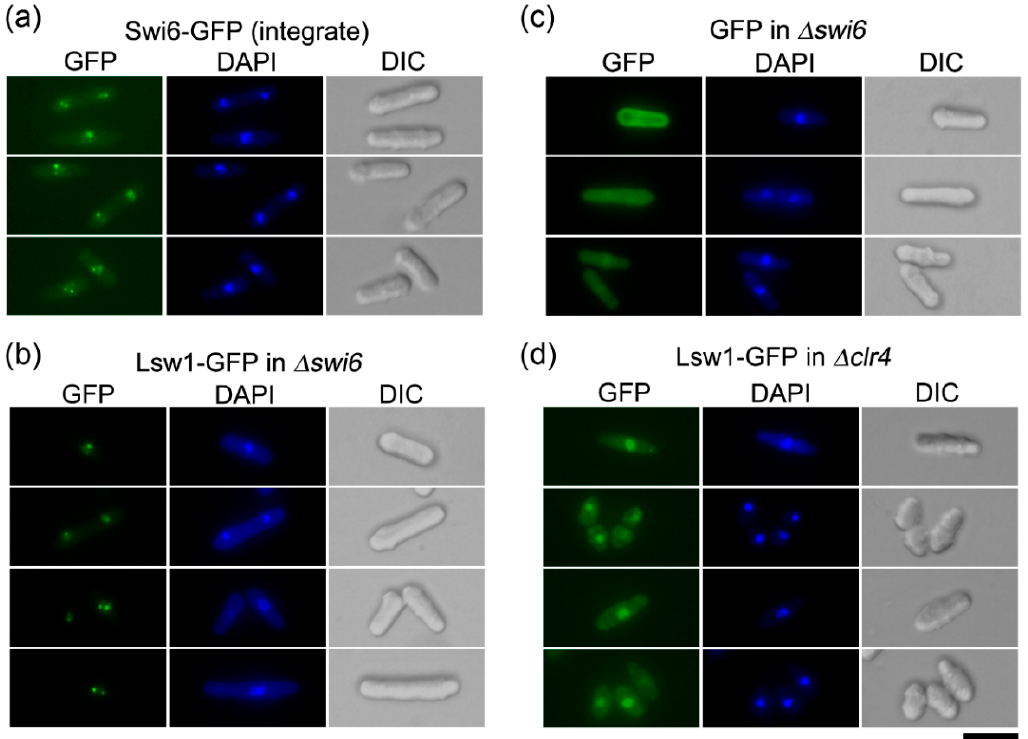
Figure 6. Lsw1 localizes to heterochromatin in a H3K9 methylation dependent manner. ( a ) Swi6-GFP (YTP1889) cells were grown in YES medium at 30 ◦ C overnight, then fixed with methanol. ( b , c ) ∆ swi6 cells (YTP1847) containing pGP4110-Lsw1 ( b ) or pGP4110 ( c ) were grown in minimal medium supplement with uracil and without thiamine at 30 ◦ C for 20 h, then fixed with methanol. ( d ) ∆ clr4 cells (YTP1840) containing pGP4110-Lsw1 were grown in minimal medium in the absence of thiamine at 26 ◦ C for 20 h, then fixed with methanol. Bar, 10 µ m.